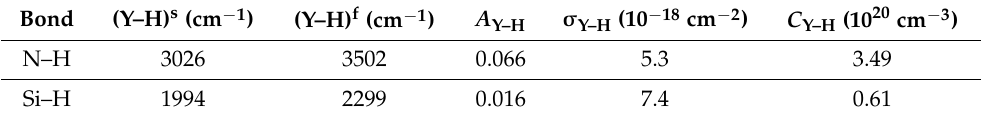
Table 2. Calculation parameters and results of the Si–H and N–H bond concentrations.